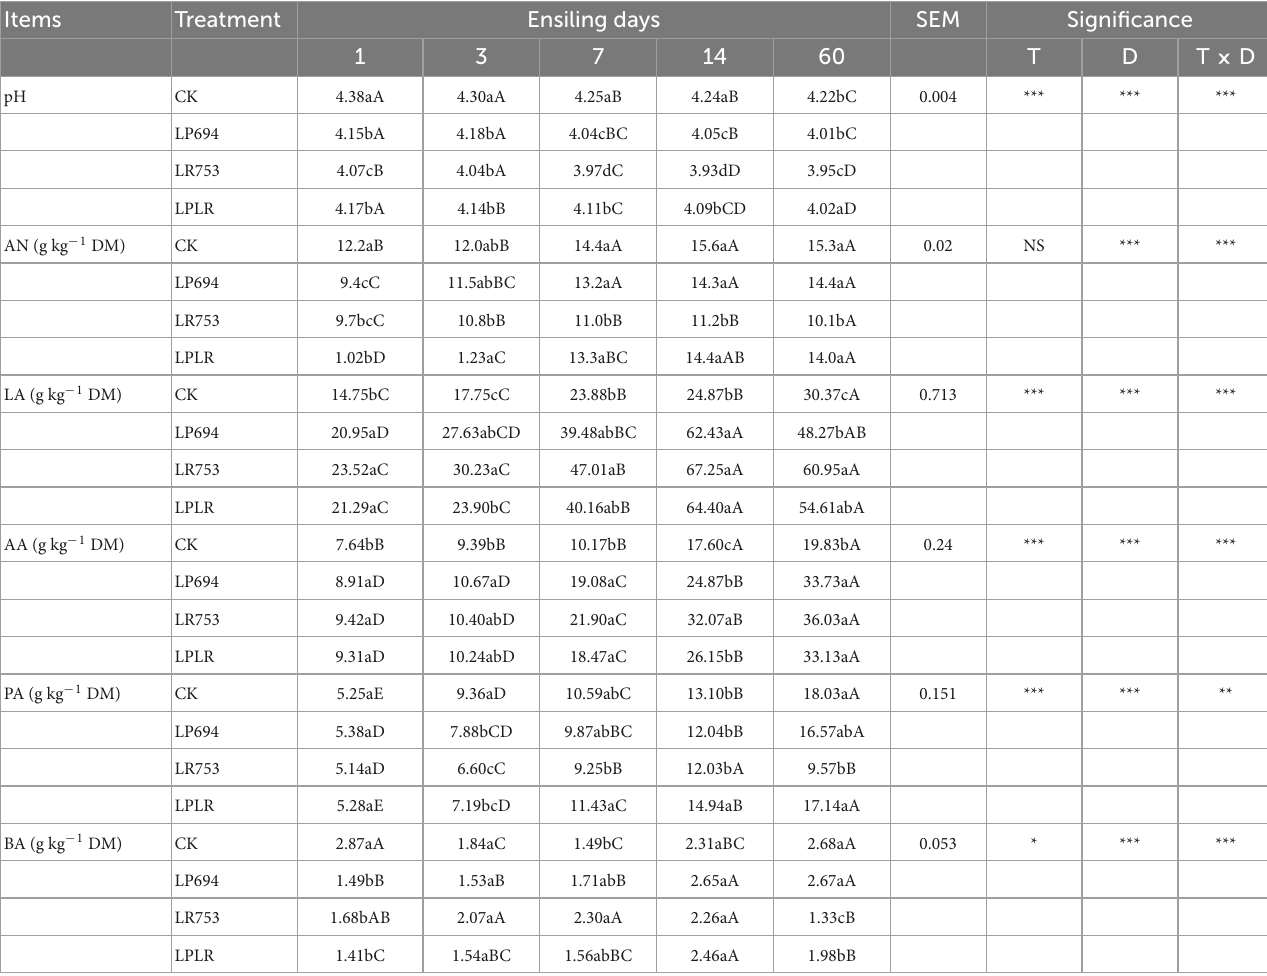
TABLE 2 Fermentation characteristics of oat silages treated with and without lactic acid bacteria. Items Treatment Ensiling days